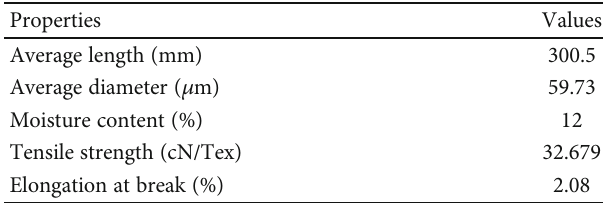
Figure 2: Pineapple fi ber-reinforced low-density polyethylene composites. Table 1: Properties of extracted pineapple leaf fi